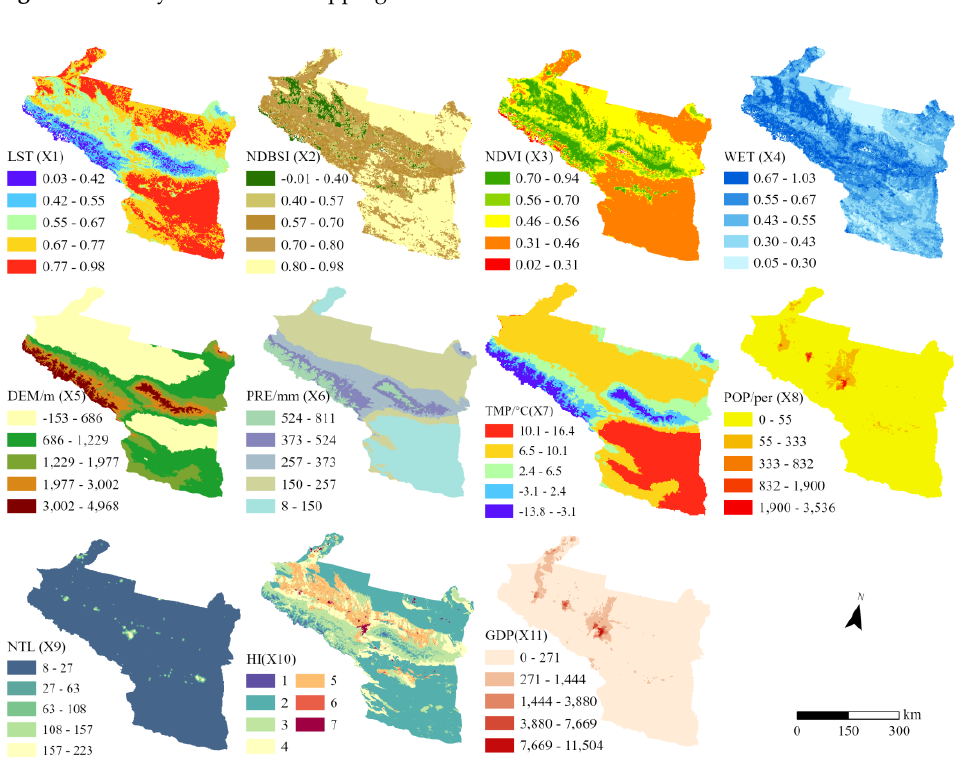
Figure 9. The 5-year median distribution of the